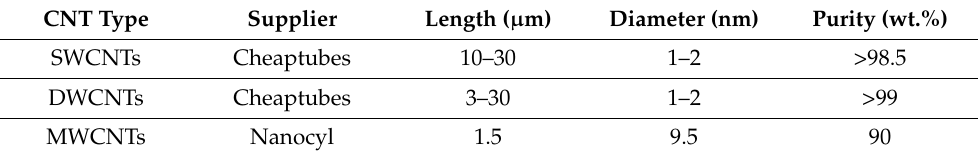
Table 1. Properties of CNTs.